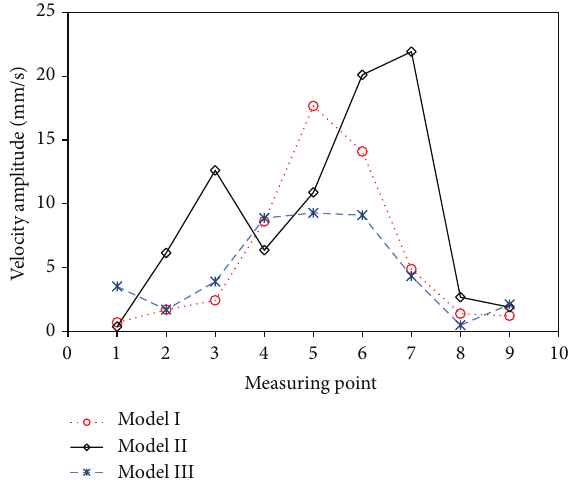
Figure 7: Velocity amplitudes at H 1 –H 9 for Models I, II, and III subjected to base excitation at 𝑓 1 .